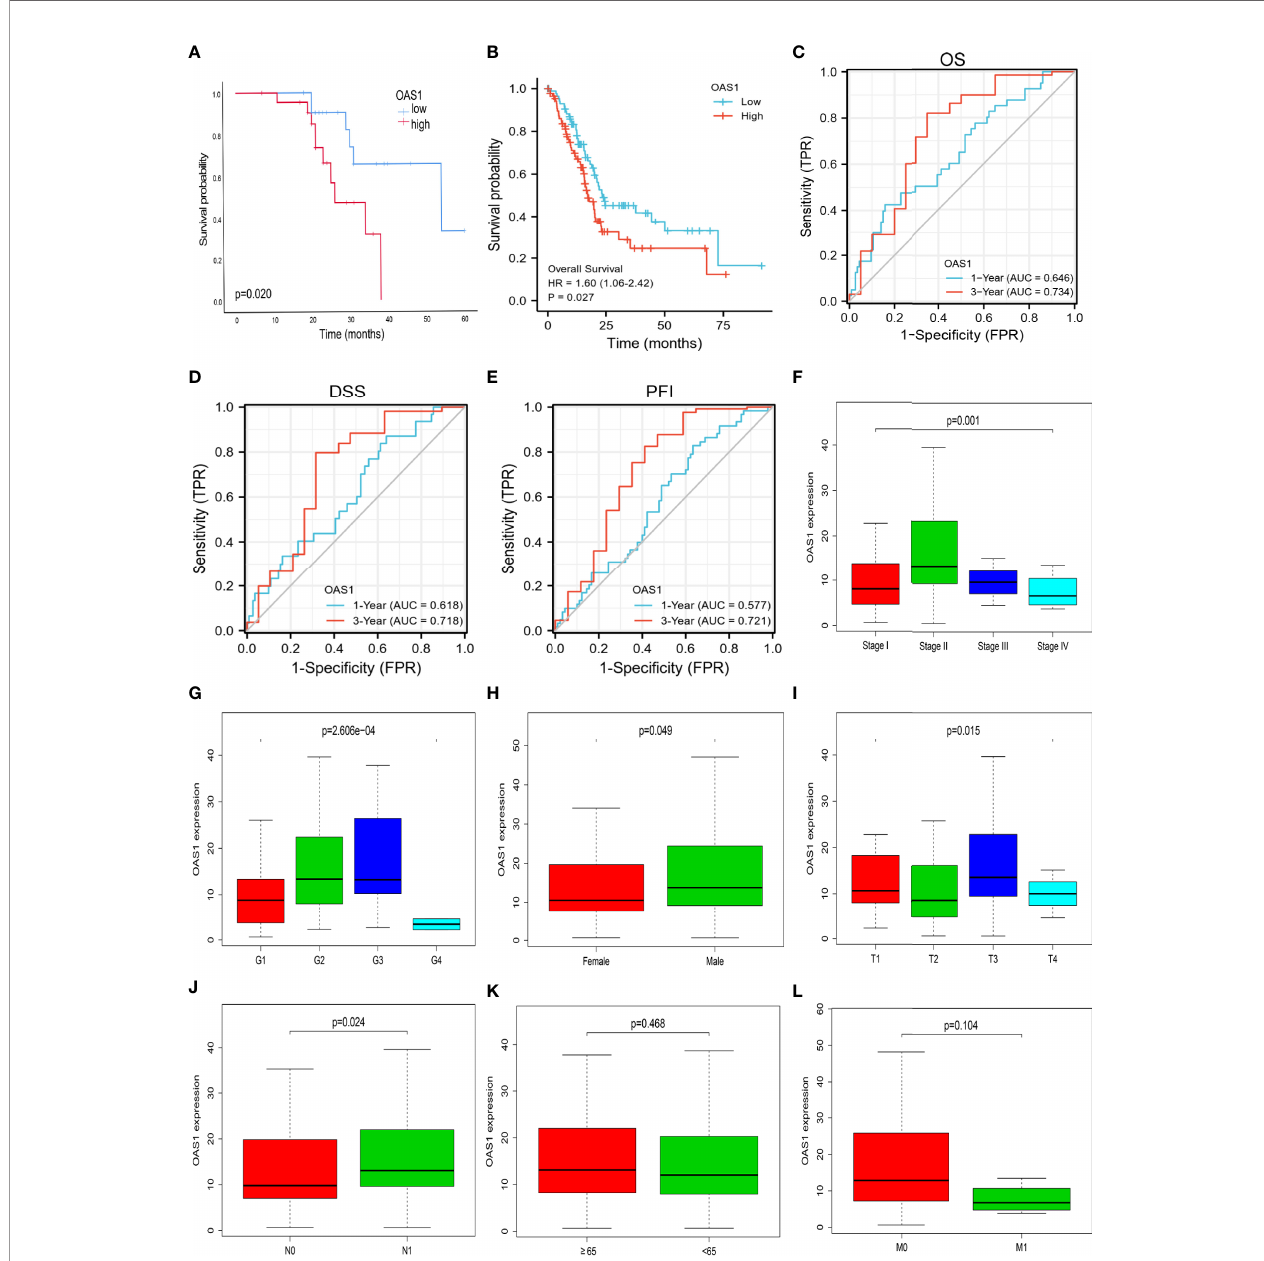
FIGURE 2 | (A, B) Kaplan-Meier survival curves for OAS1, and high expression of OAS1 has short overall survival in PAAD. The time-dependent ROC to assess the accuracy of OAS1 in predicting OS (C) , DSS (D) , and PFI (E) at 1 and 3 years. The relationships between OAS1 mRNA expression and clinical pathological characteristics. OAS1 mRNA expression was differentially expressed in different TNM stages (F) , grades (G) , gender (H) , T stages (I) , and N stages (J) . There was no difference in ages or M stages (K, L)